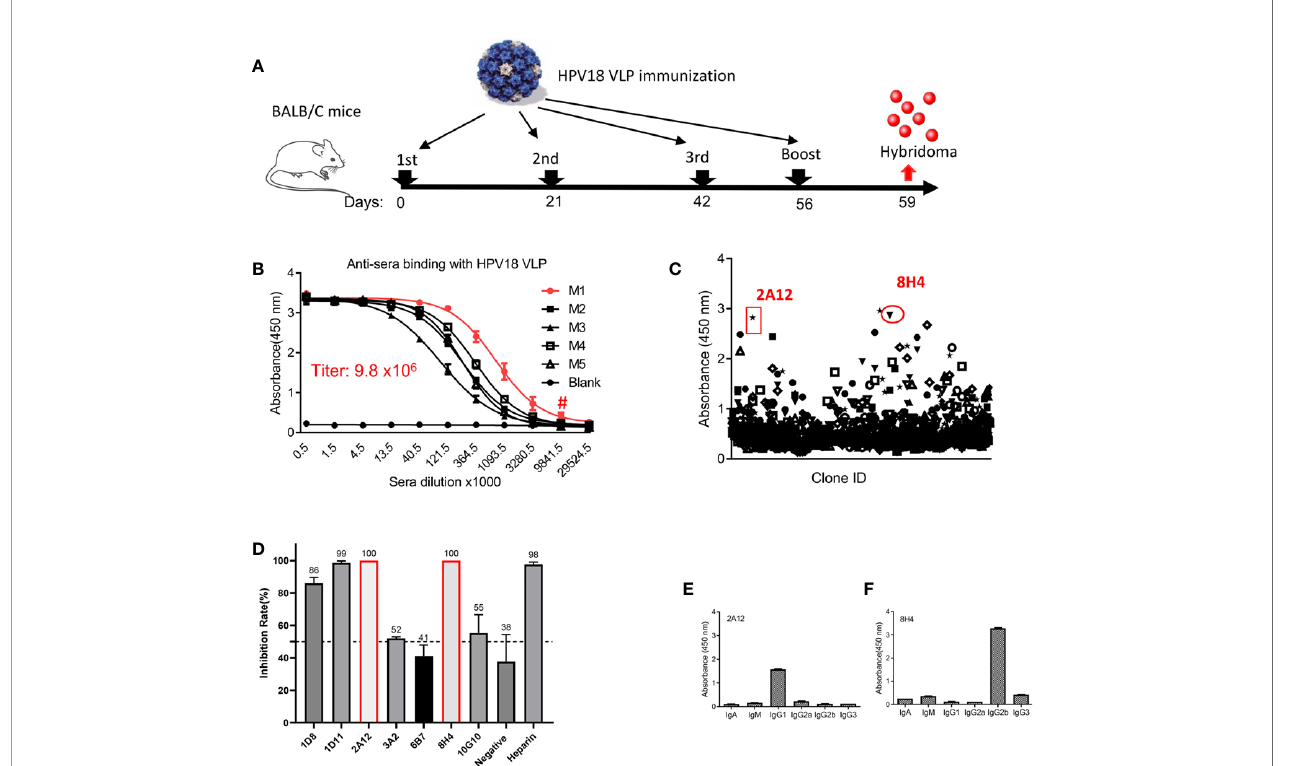
FIGURE 1 | Generation of mAbs against HPV18. (A) The experimental schedule of immunization. (B) The titer of anti-sera was evaluated after the 3rd immunization in mice receiving HPV18 VLP. Y-axis represents the absorbance at 450 nm, and X-axis is the anti-sera dilution fold. Anti-sera from fi ve immunized mice labeled with M1-5 were tested, and serum from non-immunized mice (Blank) were taken as a negative control. M1 presents the best binding (red line), a titer of 9.8 × 10 6 dilution as indicated by #. (C) The summary of hybridoma supernatant binding with HPV18 VLP astested by ELISA. Each dot represents the binding of the supernatant from one culture well containing at least one hybridoma. Two dots, shown by red circle, indicate the parental clones of 2A12 and 8H14, respectively. (D) Top seven binders in (C) inhibiting HPV infection, each dot represents one hybridoma supernatant. Cell supernatant and heparin were taken as negative and positive controls, respectively. Two clones present complete inhibition were highlighted with red frame line. Subtype of 2A12 (E) and 8H4 (F) was tested by Subtype identi fi cation kit. Data of (B, D – F) represent mean ± SEM. All experiments of (B – F) were repeated